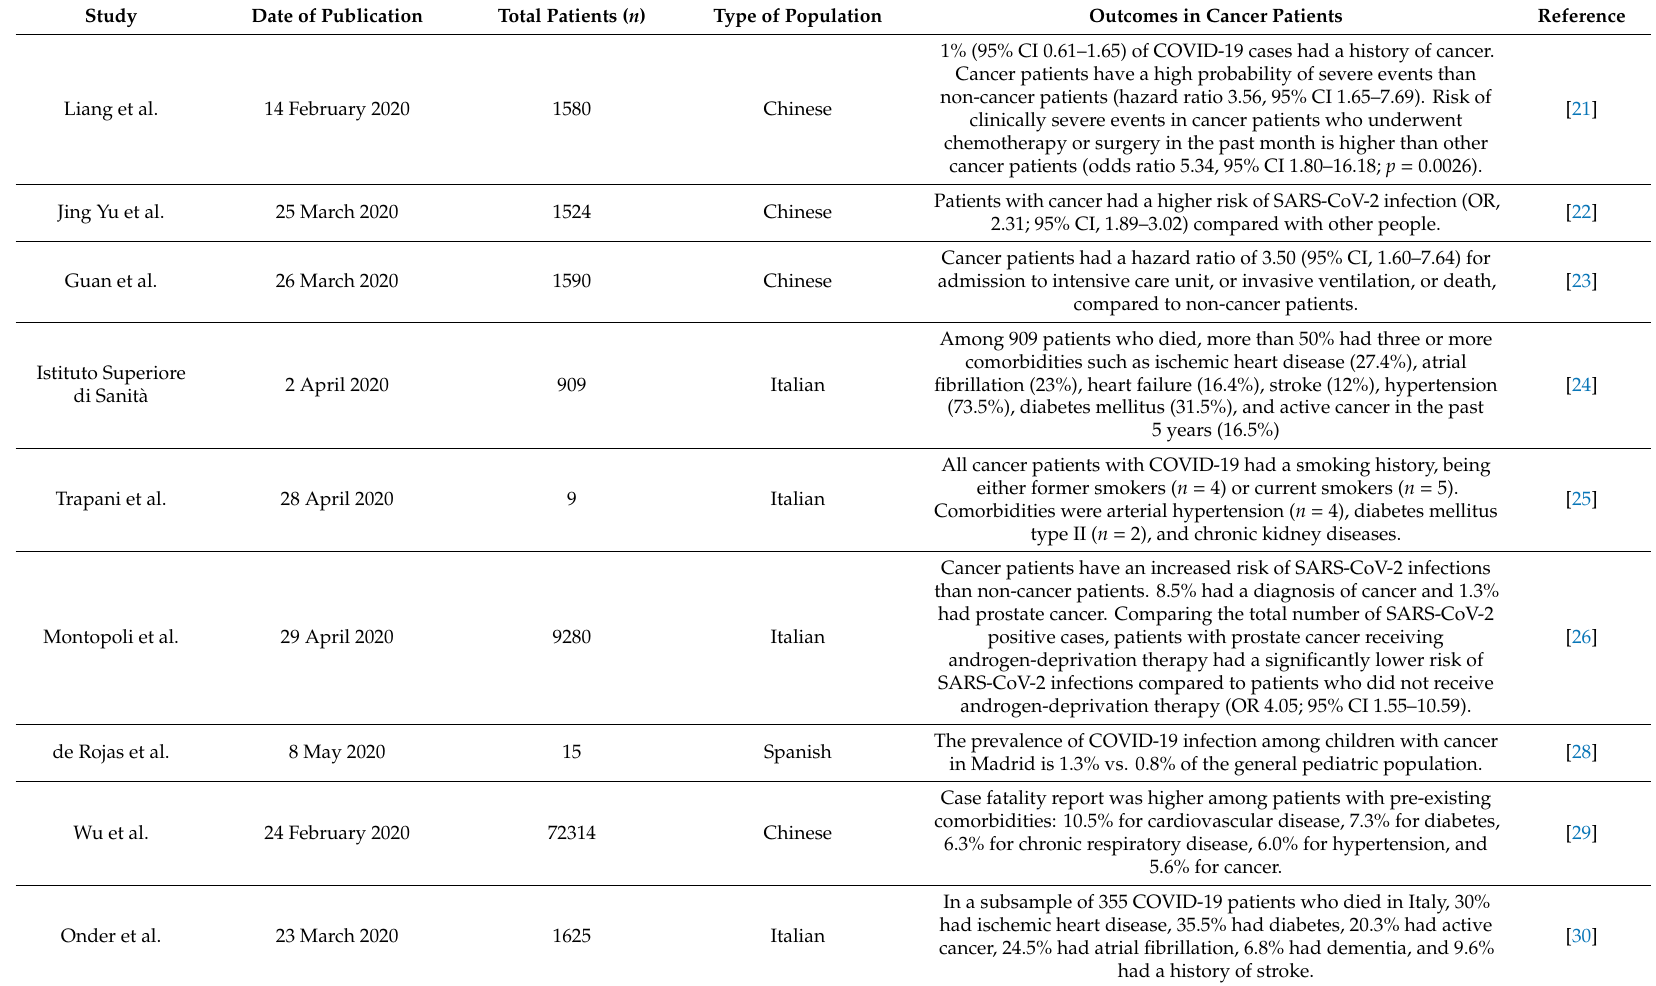
Table 1. Retrospective clinical studies on cancer patients a ff ected by SARS-CoV-2